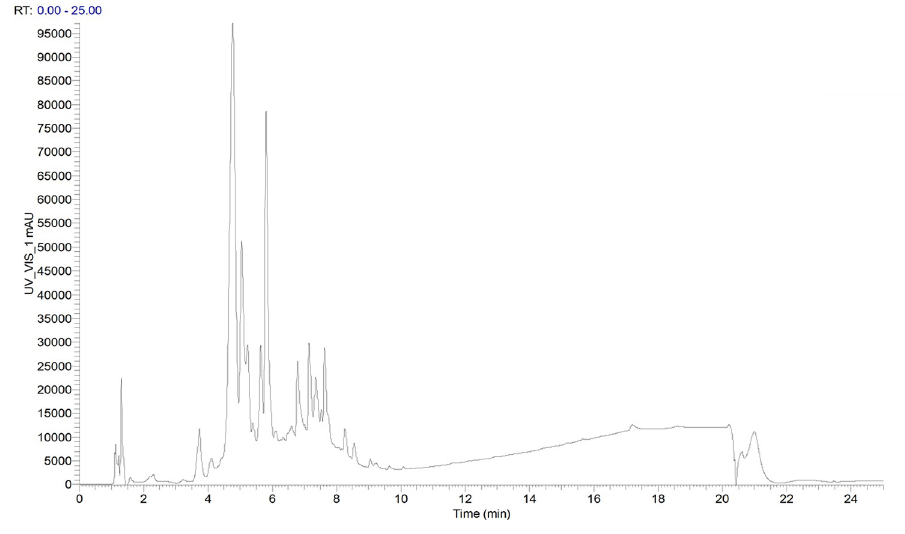
Fig 12. UV-Vis spectrum at 280 nm of lingonberry